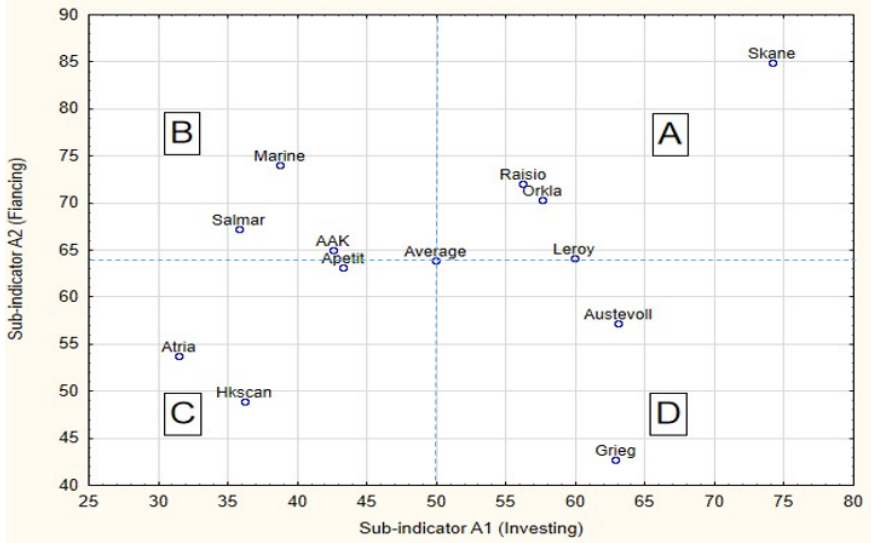
Fig. 7. Strategies for working capital management of food companies from Northern